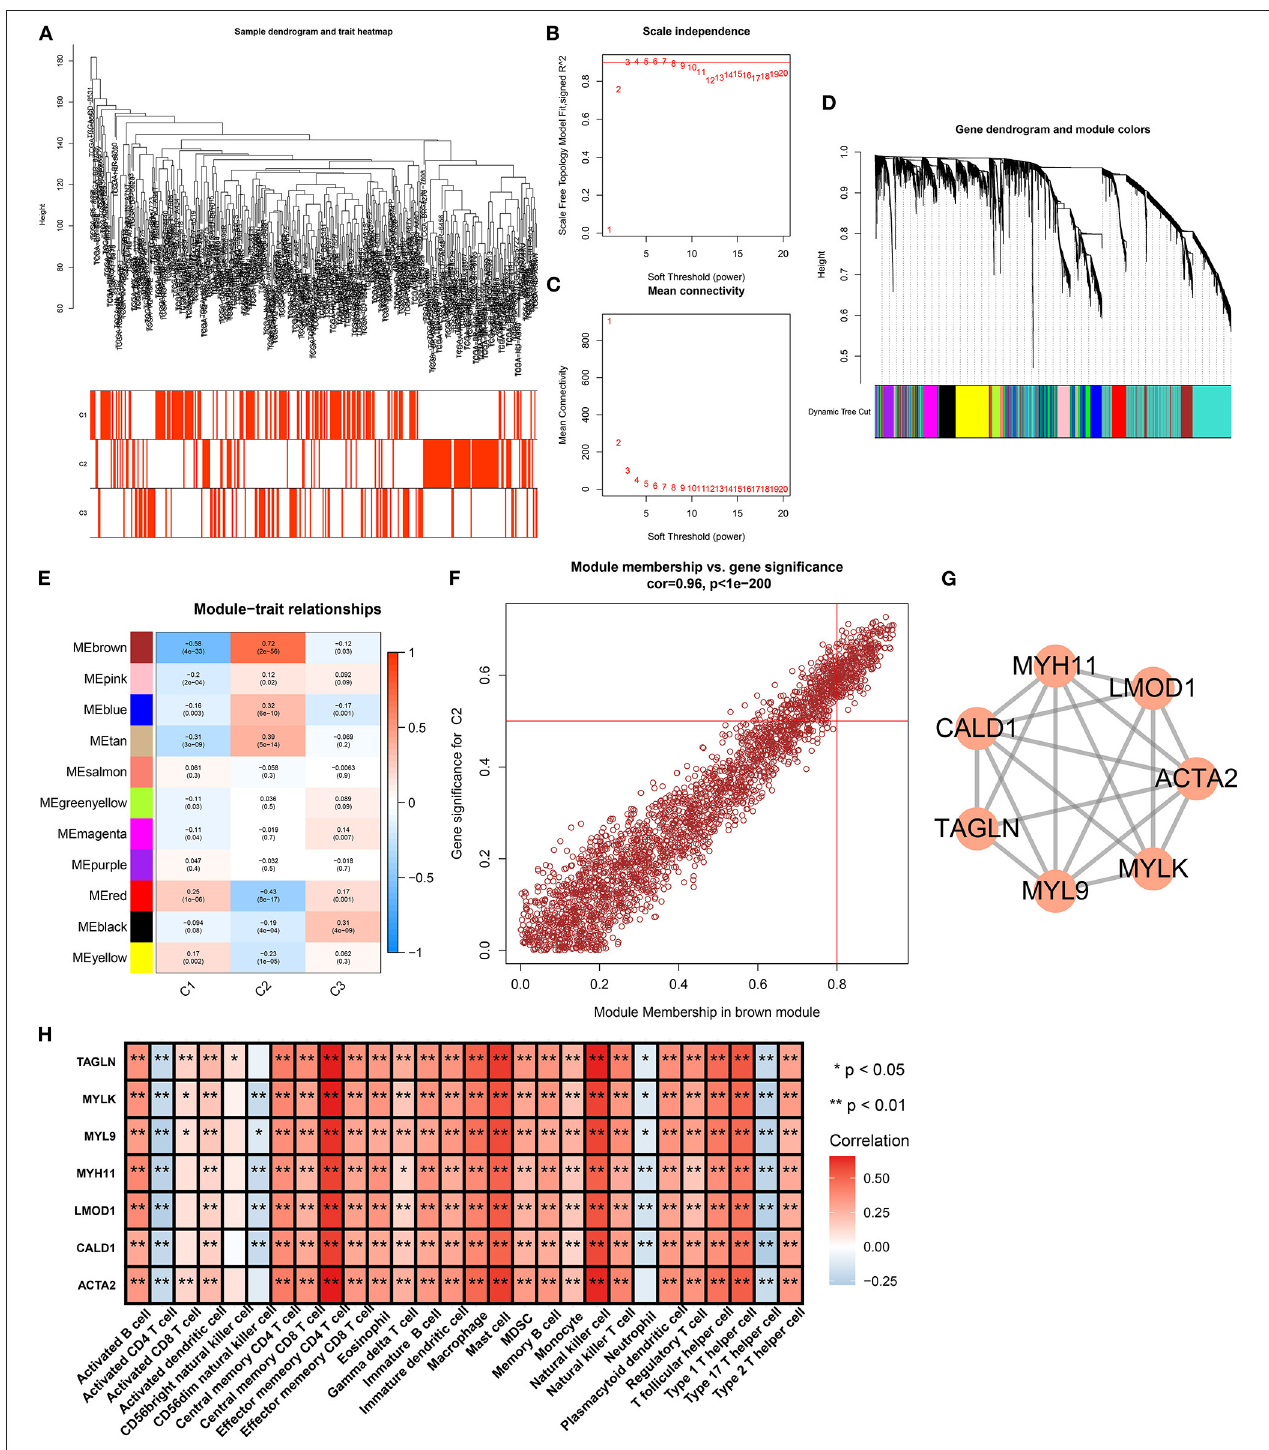
FIGURE 6 | Identification of aging molecular phenotype-relevant key genes. (A) Sample dendrogram and heatmap were conducted based on transcriptome data of gastric cancer. The color intensity indicated aging-associated molecular phenotypes (C1, C2, and C3). (B) The scale-free fitting index was determined across diverse soft thresholding powers. (C) Mean connectivity was analyzed under different soft thresholding powers. (D) Clustering dendrogram was conducted on the basis of co-expression network analyses. Totally, 11 co-expression modules were merged as well as uniquely identified by diverse colors. (E) Heatmap showed the correlation between co-expression modules and aging-associated molecular phenotypes across gastric cancer. The brown module presented the strongest correlation module with phenotype C2. (F) Scatter plots depicted the interactions of module membership in the brown module with gene significance for phenotype C2. (G) MCODE analyses identified the most prominent module in the PPI network of genes in the brown module. (H) Heatmap visualized the interaction between the hub genes and the infiltration levels of immune cells. * p < 0.05; ** p < 0.01.